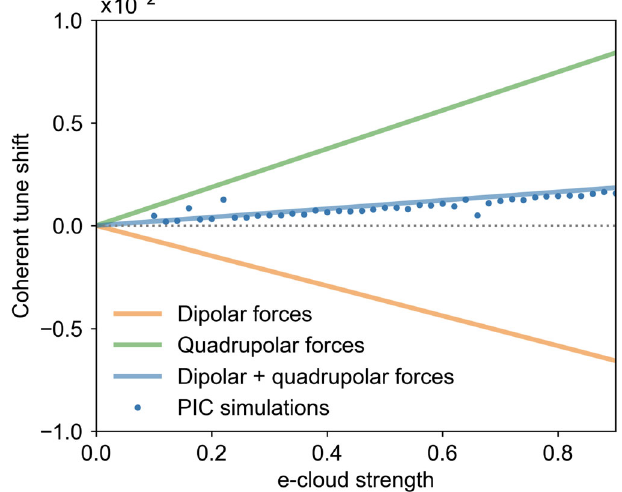
FIG. 12. Tune shift of the “ rigid-bunch ” mode estimated with the Vlasov approach (continuous lines) and obtained by macro- particle simulations performed with the PIC